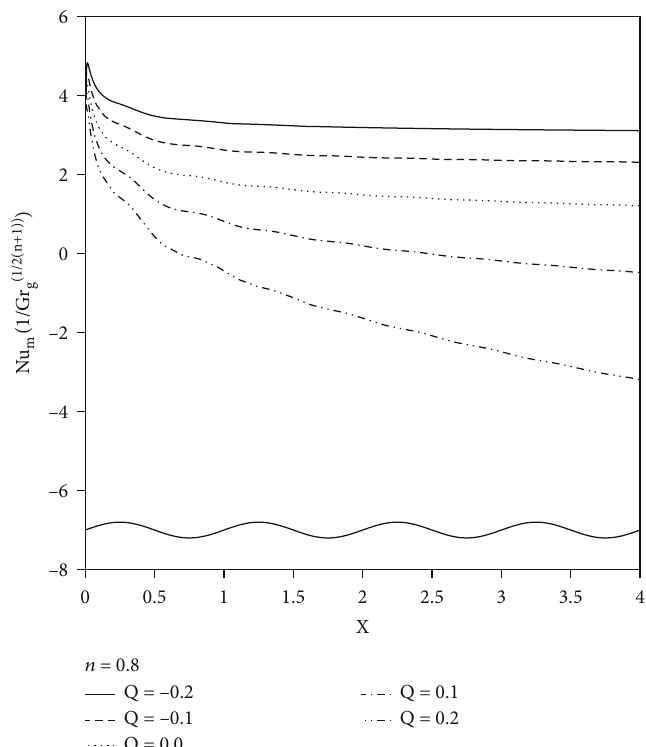
Figure 16: The axial distribution of the mean Nusselt number for P = 50 , α = 0 : 25 , Br = 0 : 5 , and n = 0 : 8